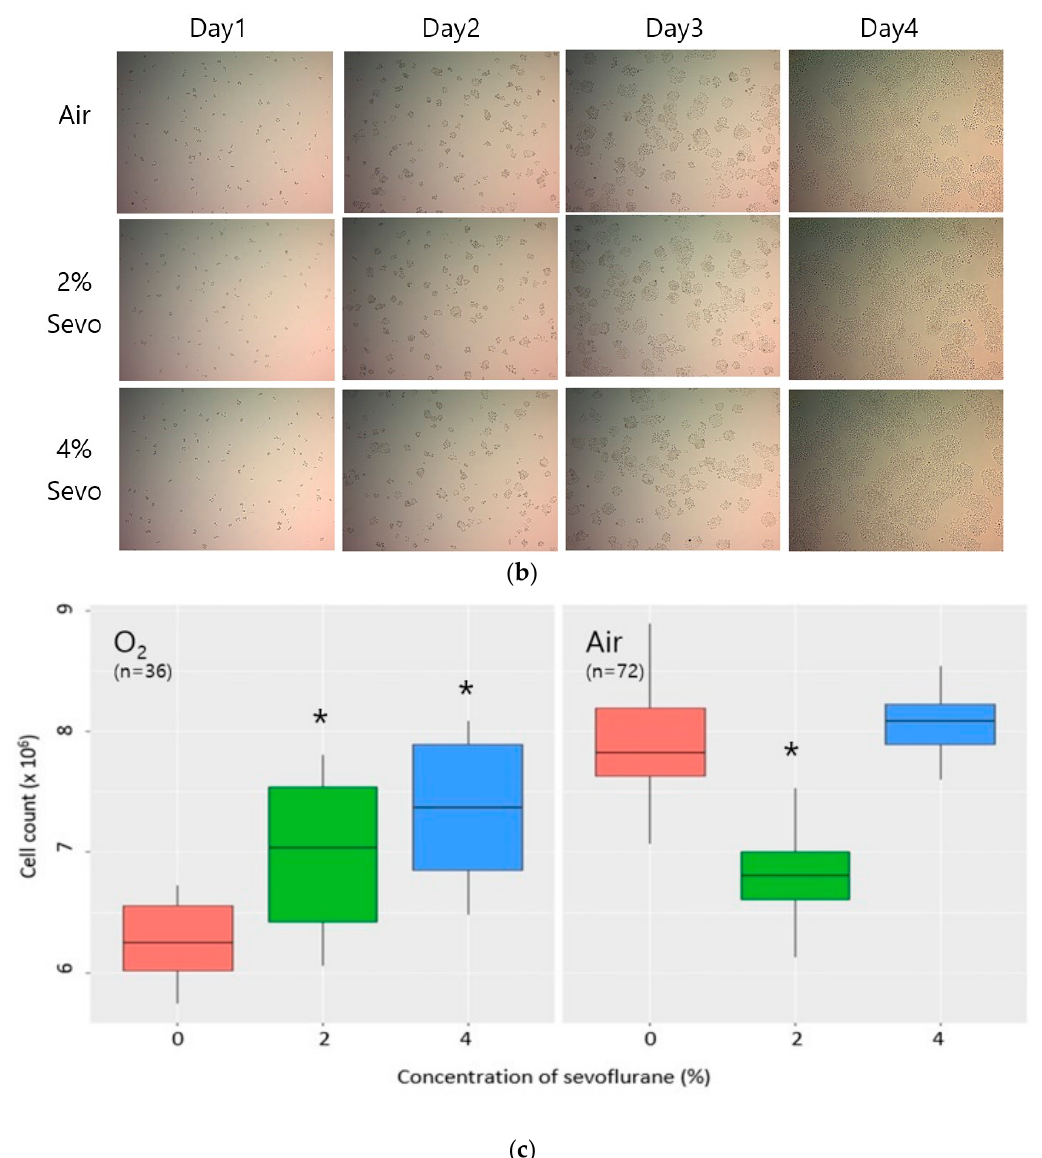
Figure 4. A549 cancer cell proliferation after sevoflurane exposure in vitro studies. ( a ) Representative microscopic images when A549 cells were exposed to 0%, 2%, or 4% sevoflurane with oxygen or ( b ) with air for three days ( × 40). ( c ) A comparative analysis of the number of A549 cells exposed to the different concentration of sevoflurane with oxygen (left figure, total n = 36) or air (right figure, total n = 72) on day 4. Data are presented as the mean ± SD. * represents p < 0.01, compared with 0% sevo fl urane.